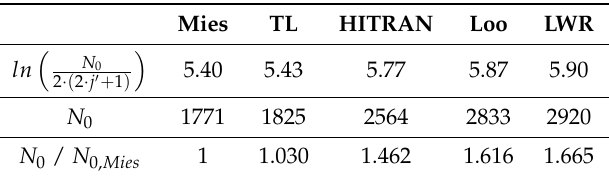
Table 3. The N 0 populations of the median OH ( 4 − 2 ) spectrum in Figure 1 calculated using the Einstein A coefficients of Mies, TL, HITRAN, Loo, and LWR. Line 1 of the table is log of the population of N 0 , and line 2 is the column density in units of 10 6 molecules/cm 2 . Line 3 is the ratios of the N 0 populations normalized by N 0, Mies . Mies